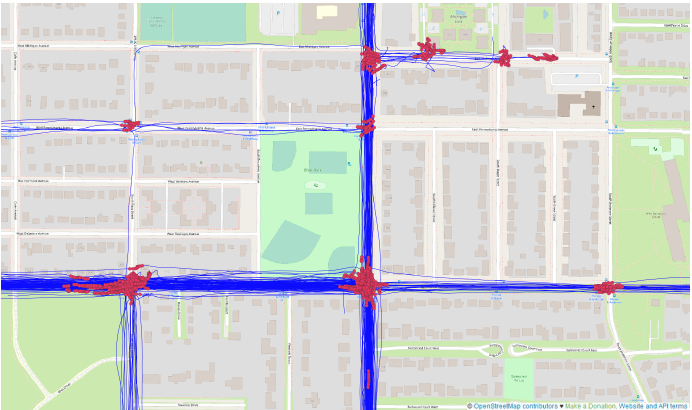
Figure 4. Stop events (red points) detected from the CB-SDoT algorithm in vehicle trajectories (blue